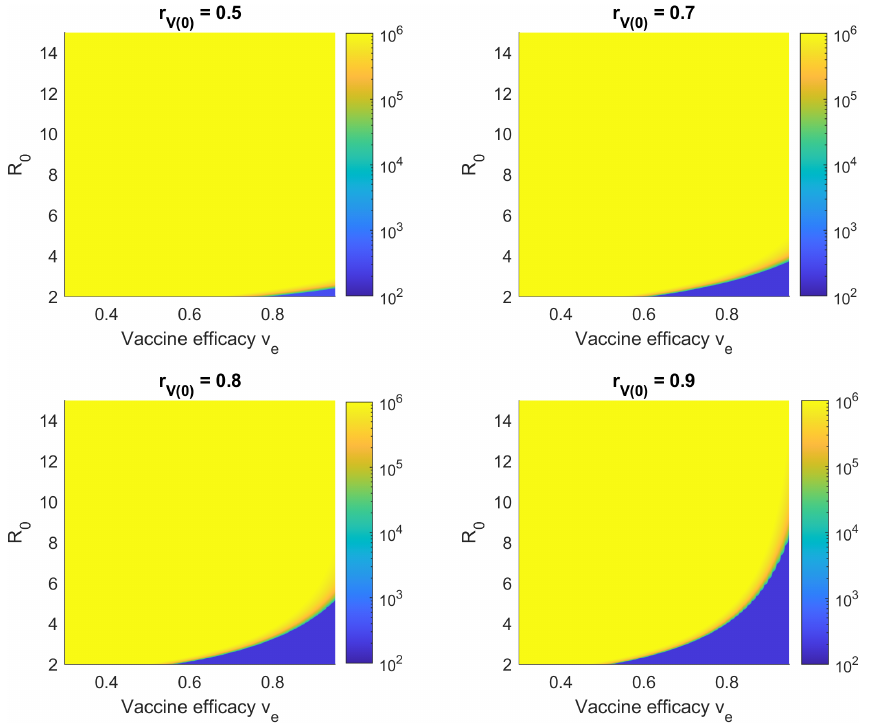
Figure 9. Cumulative hospitalizations and isolations H c ( ∞ ) with respect to R 0 and the vaccine efficacy v e for a simulated epidemic outbreak and no NPIs ( c = 0). The area of the blue region, representing lower total infections/hospitalizations, increases with respect to r V ( 0 ) , the initial vaccination